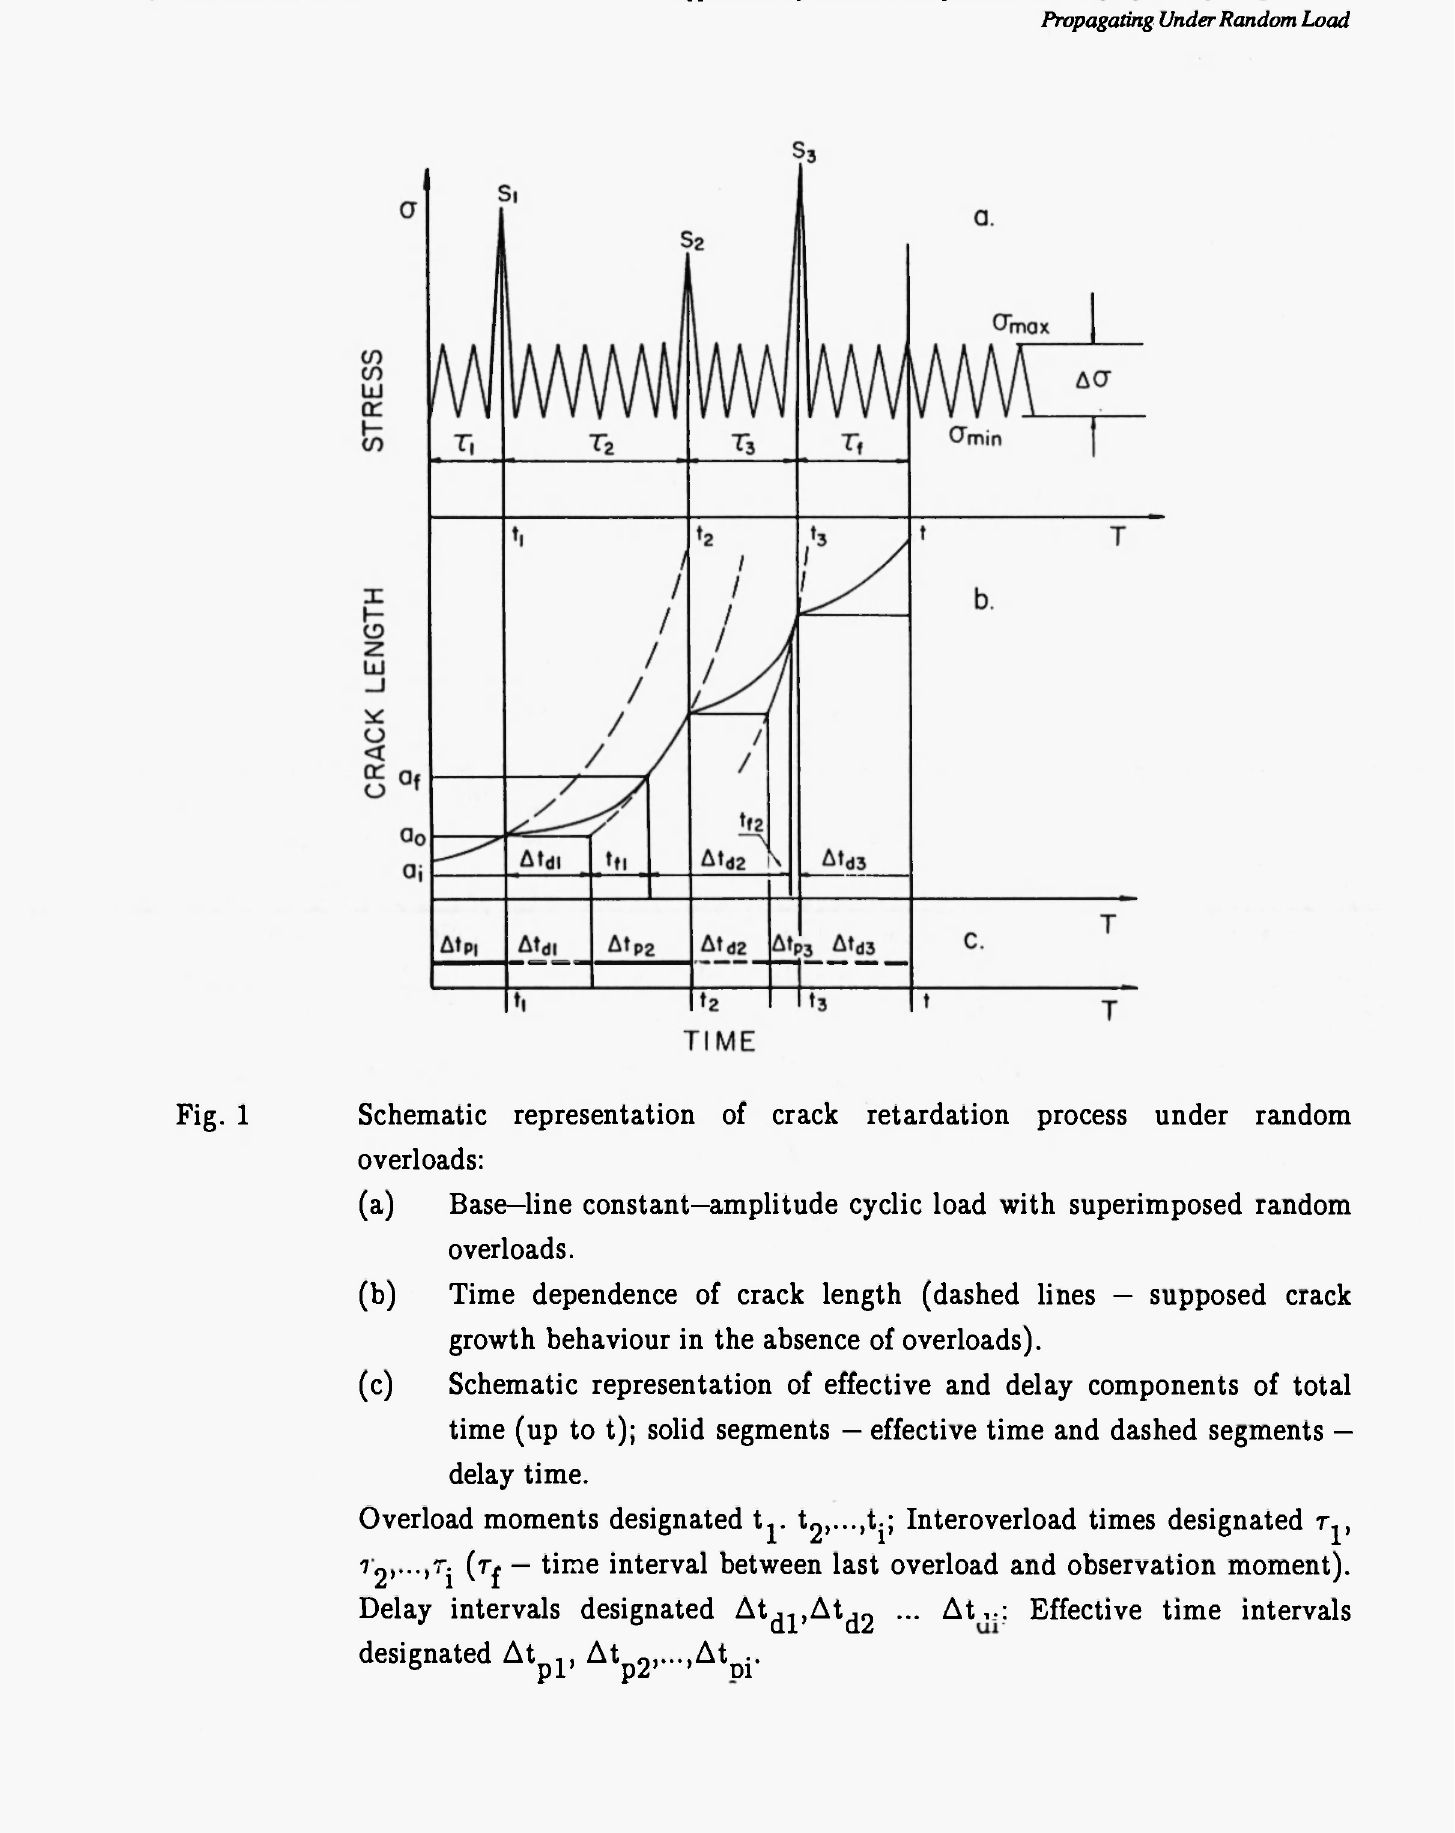
Fig. 1 Schematic representation of crack retardation process under random